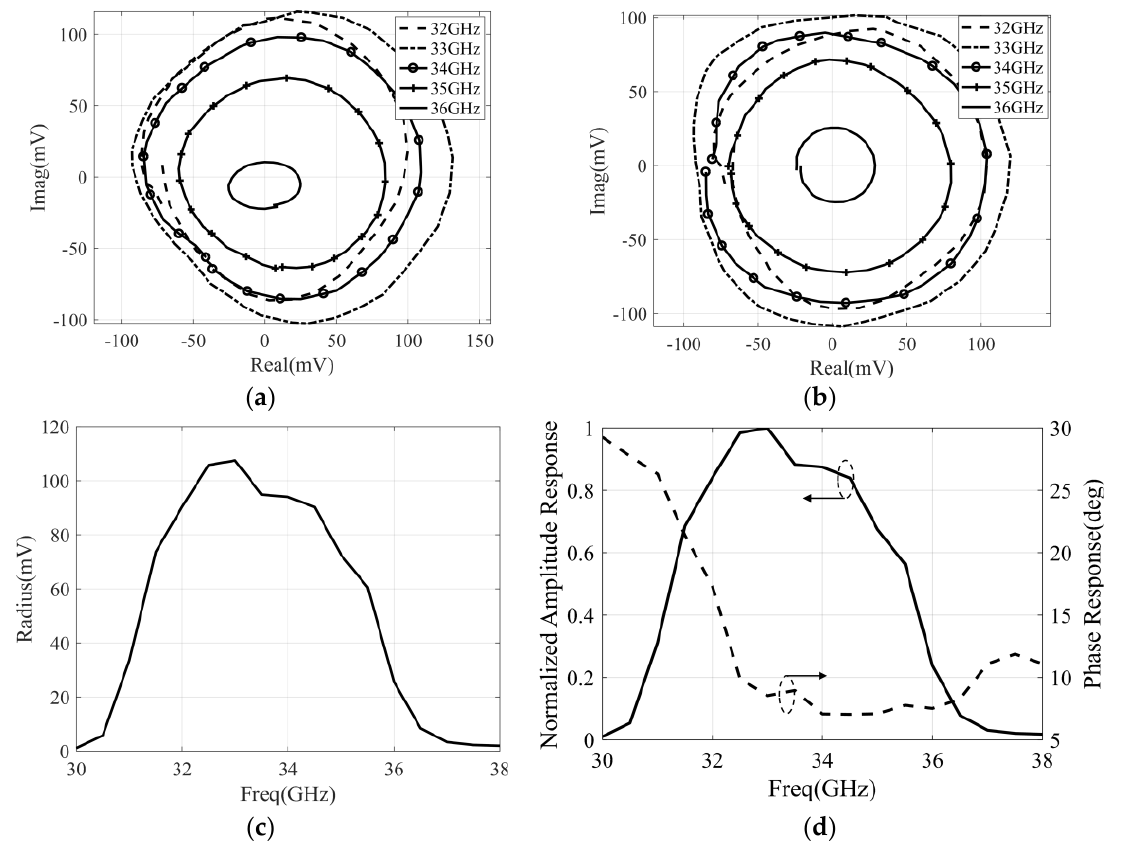
Figure 14. The measurement and calibration results of the correlator under the condition that the power of the input signals is − 35 dBm and the frequency varies from 30 to 38 GHz: ( a ) measured correlation circle; ( b ) calibrated correlation circle; ( c ) the variation in correlation circle radius with frequency; ( d ) the amplitude response and phase response versus frequency.